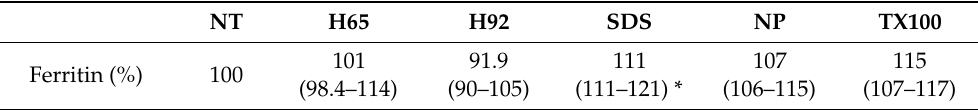
Table 1. Ferritin in saliva after the different inactivation SARS-CoV-2 treatments. Results were normalized according to NT measurements, which was considered 100% and expressed as median (25–75 percentile). Asterisk indicates differences of statistical relevance vs. NT measurements